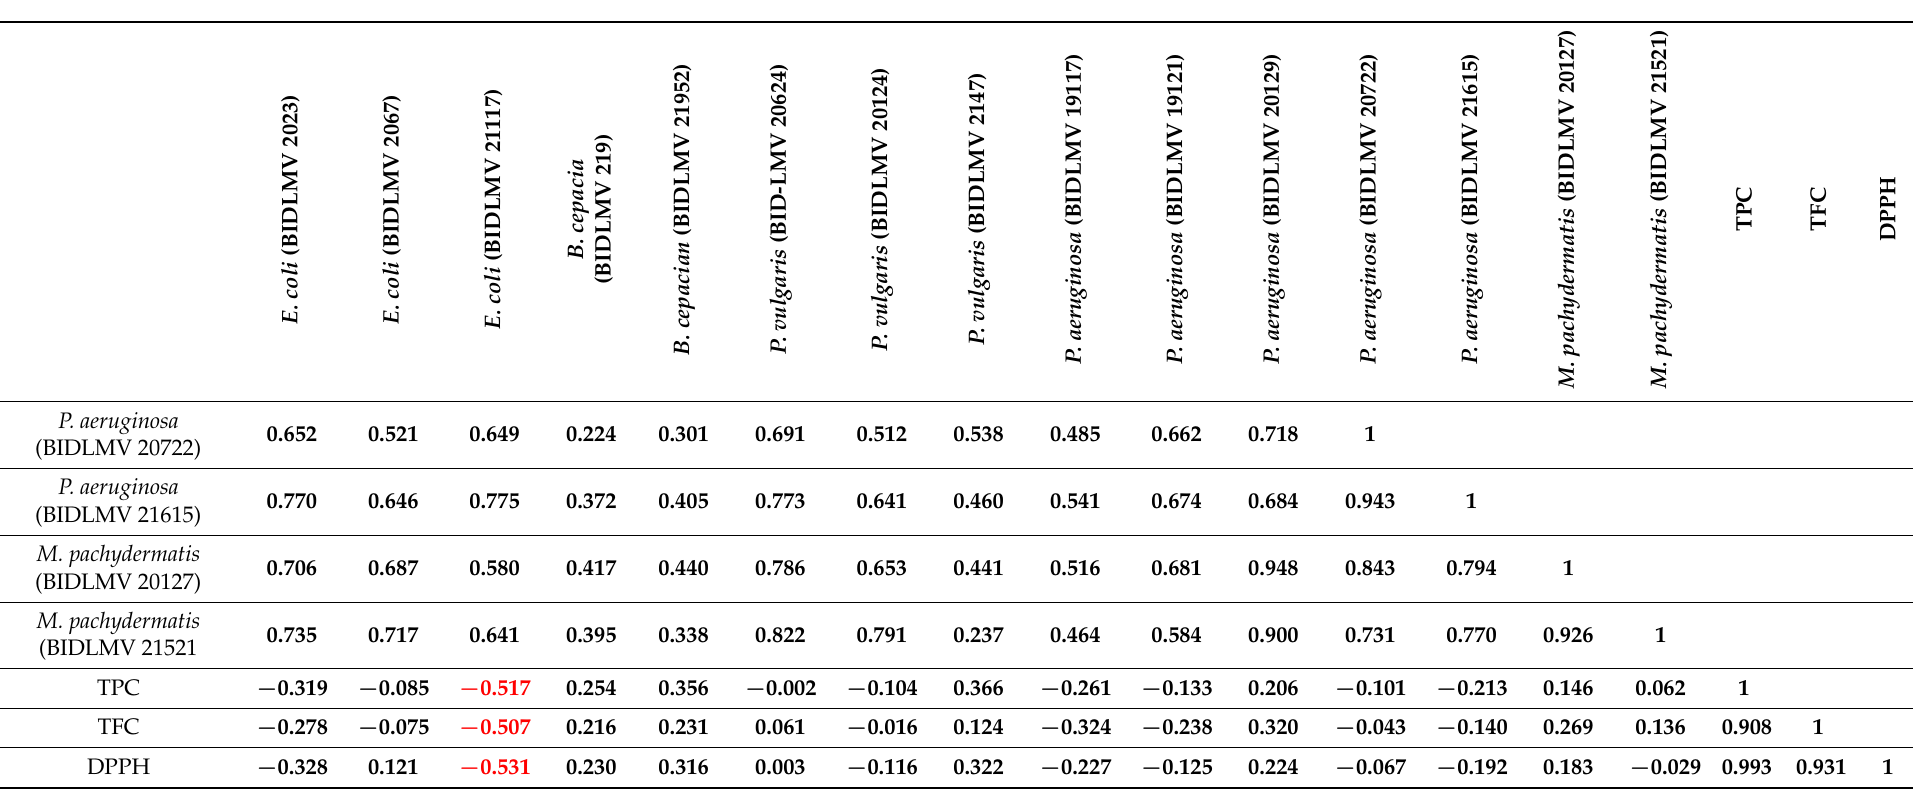
Red colored values highlight the existence of significant correlations between